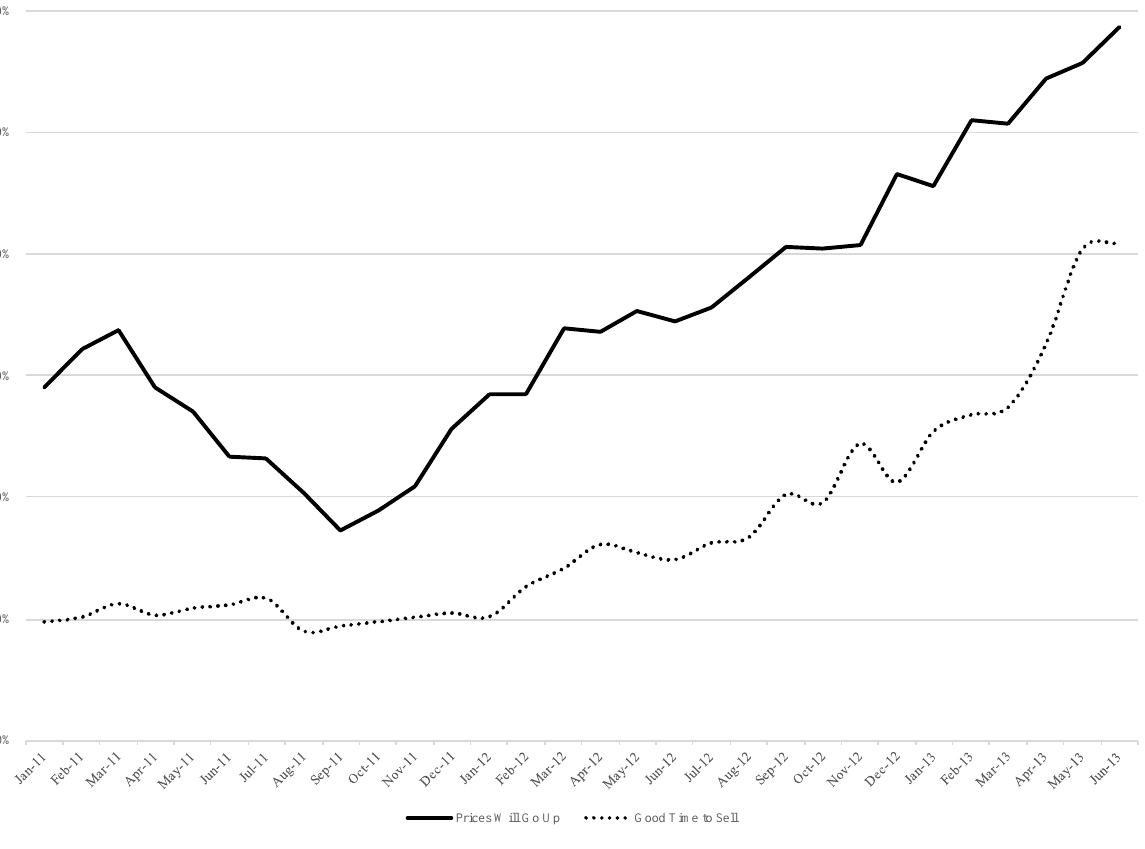
Figure 1. Housing market expectations, January 2011 to June 2013.